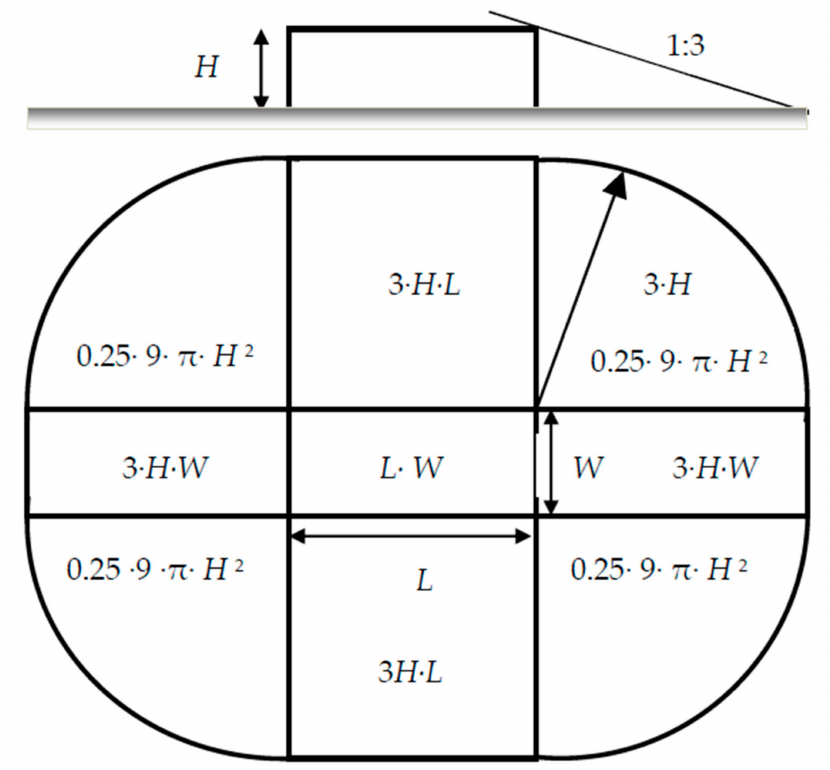
Figure 2. Graphical description of the equivalent collection area of discharges into an object, where: H—height, L—length: W—width